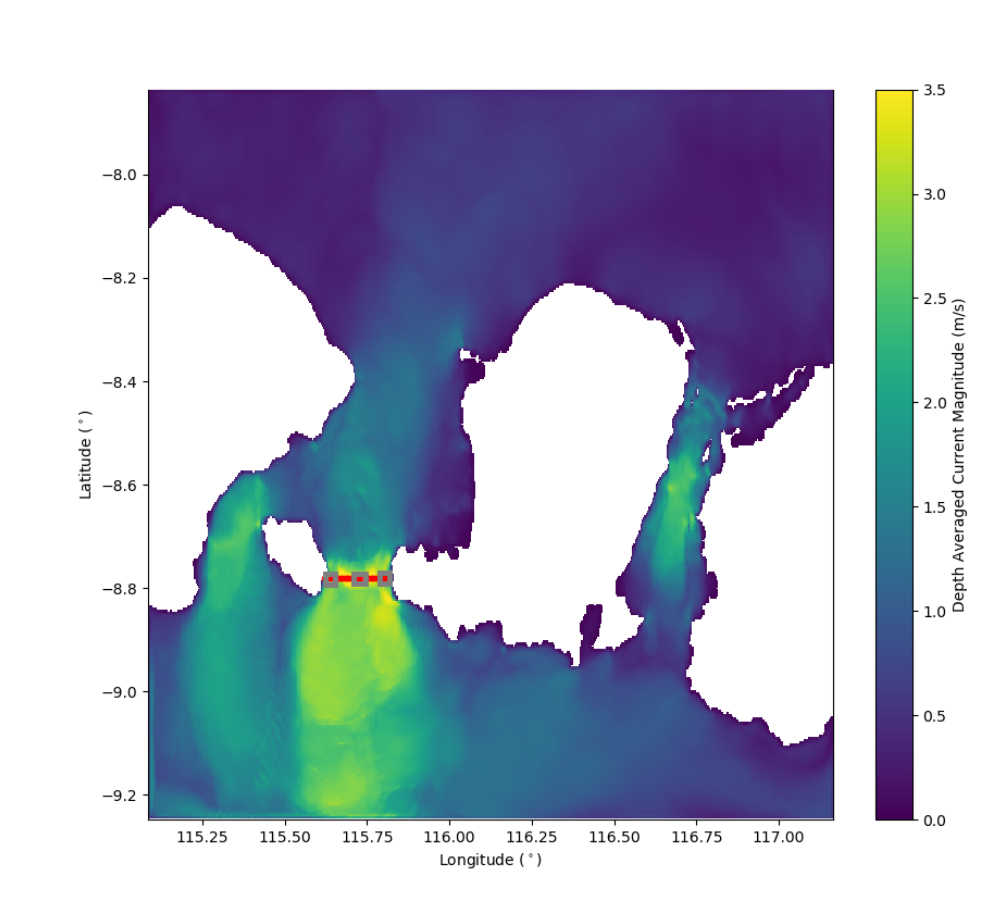
Figure 10. Maximum current velocity for tide only simulation. Red line indicates the cross sectional area extracted for the analysis and grey boxes each of the three locations analysed for Figure